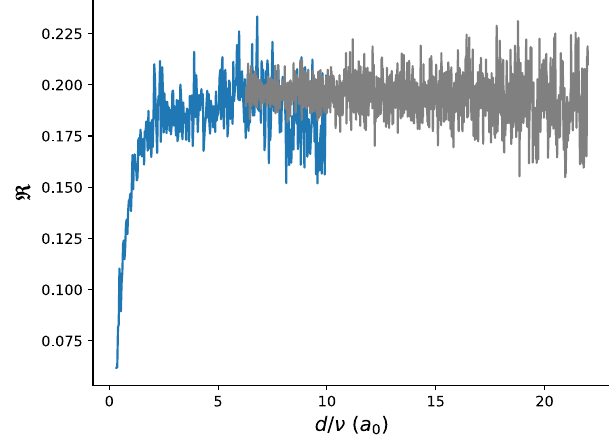
FIG. 12. Numerically obtained AGR for a Rydberg composite with ν ¼ 30 (blue) and ν ¼ 100 (gray) for a filled lattice ( F ¼ 1 ) as a function of d= ν